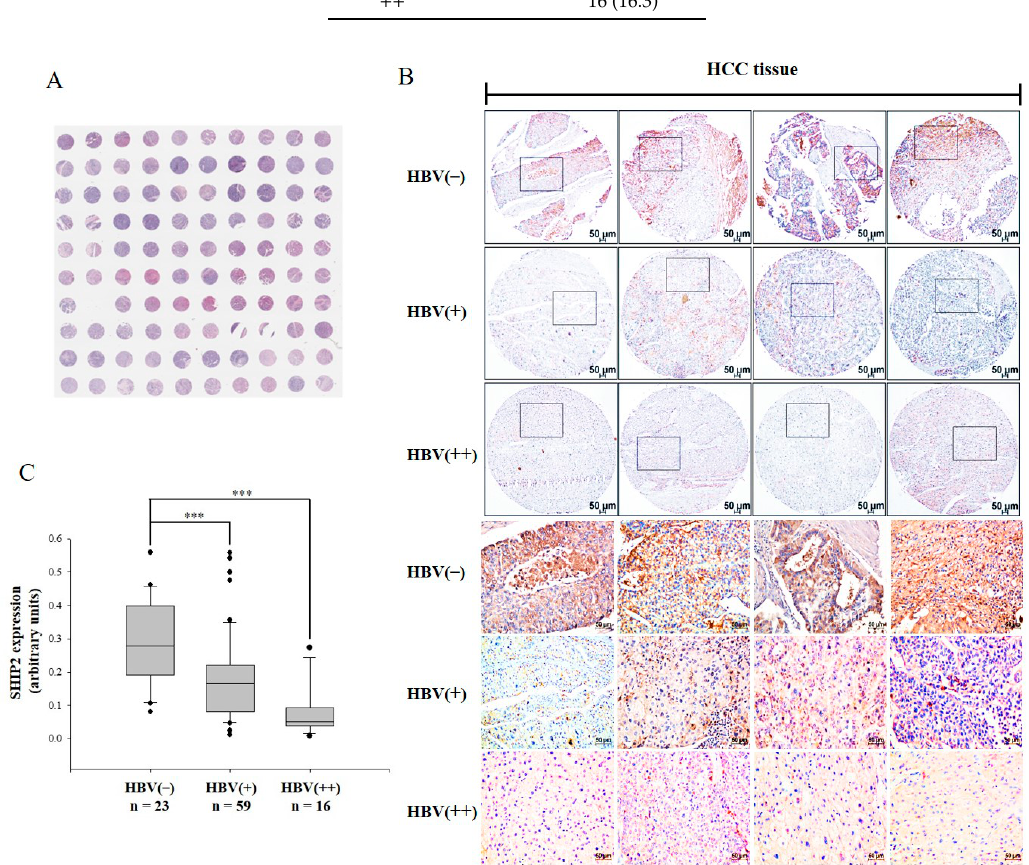
Figure 1. SH2 domain containing inositol 5-phosphatase 2 (SHIP2) is downregulated in human hepatocellular carcinoma (HCC) tissue with hepatitis B virus (HBV) infection. ( A ) Representative hematoxylin and eosin (H&E)-stained tissue microarray (TMA) slide, containing 98 duplicate core tissue samples from 49 individuals with HCC. Scale bar: 50 μ m. ( B ) Expression of SHIP2 in human HCC tissue without or with HBV infection was examined by immunohistochemistry (IHC) analysis of the TMA, which was stained with human SHIP2 antibody. Representative cores from the human HCC TMA are shown, and the areas within the black squares are enlarged and presented in the lower panels. ( C ) Quantification of IHC intensity for SHIP2 in cores grouped according to HBV infection status. Data represent the mean ± standard deviation (s.d.), *** p < 0.001.